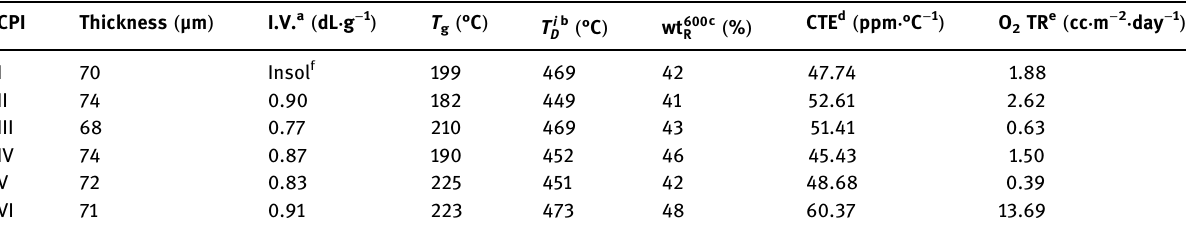
Table 2: General properties of CPI fi lms obtained from the CHDA monomer CPI Thickness ( μ m